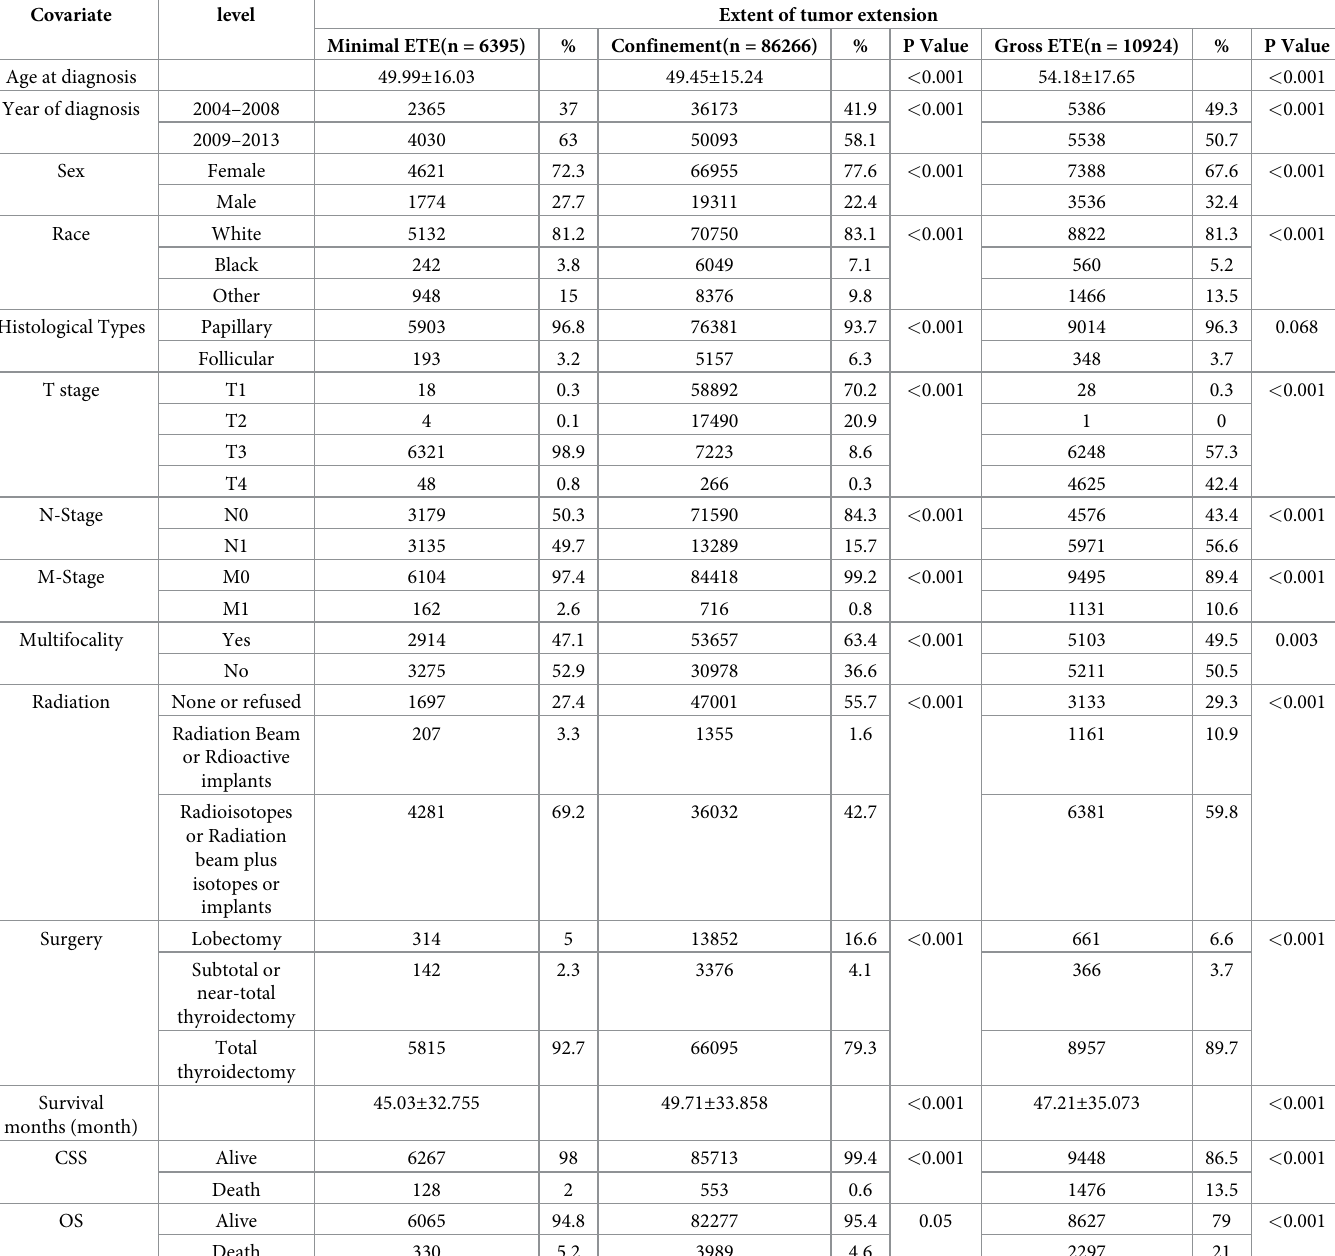
Table 1. Characteristics for patients with different extent of tumor extension.